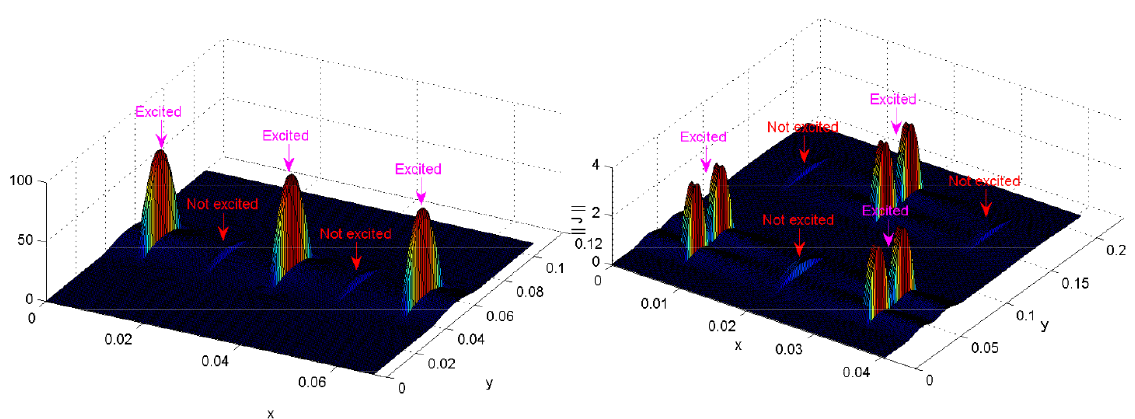
Figure 15. Current densities: 1D and 2D of aperiodic array examples (half-wave dipoles) lying on the guide wave’s aperture and described by the basis functions (guide’s modes) at the operat- ing frequency (f) of 5.4 GHz. The physical parameters were: α 0 = 0 rad m − 1 , β 0 = 0 rad m − 1 , w = 1 mm, δ = 0.75 mm ( w (cid:28) λ 0 , δ (cid:28) λ 0 ) , d x = 13.5 mm, d y = 108 mm, L = λ 0 h = 1.25 mm, and (cid:101) = (cid:101) r = 1 (air).